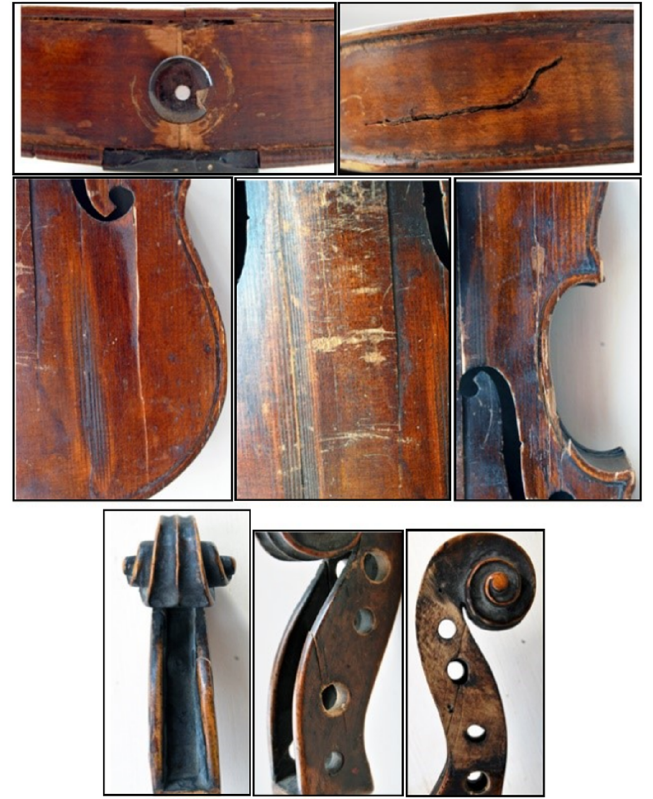
Figure 3. Details with visible elements of the preservation state of the violin.